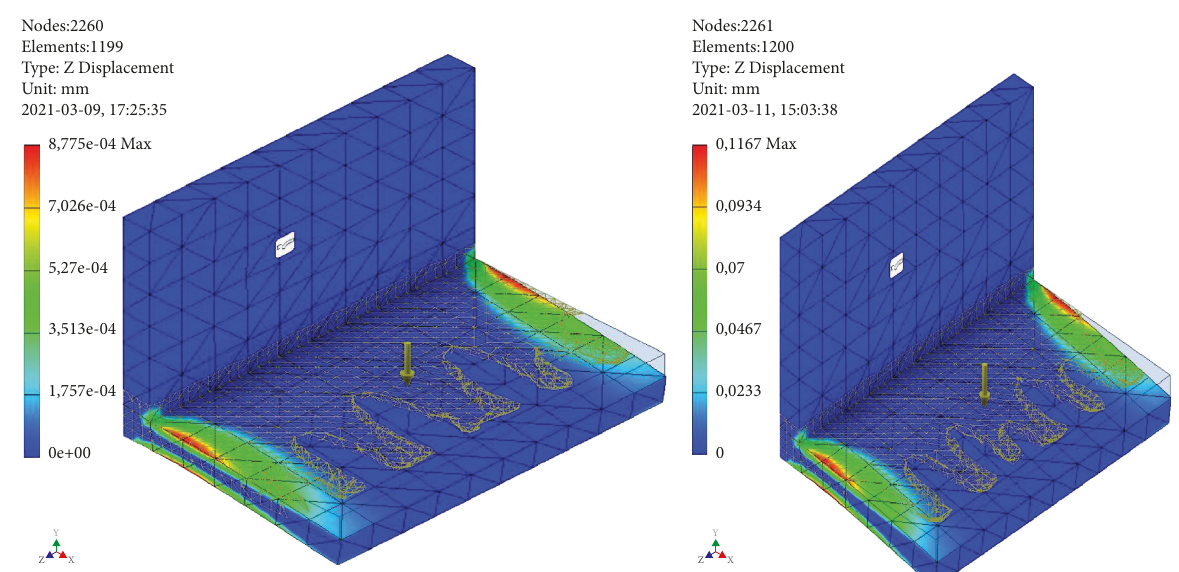
Figure 7: Topology optimized compliant L-clamp displacement— Z direction.